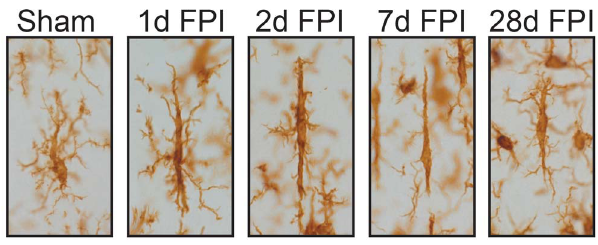
Figure 2. Rod microglia morphology and alignment post-FPI. Representative images of Iba1-positive microglia in the cortex of sham- injured and FPI rats. Sham-injured microglia showed a sausage-like cell body but no polarization of processes. However, as early as 1 day post- injury the retraction of planar processes was evident giving rise to rod morphology. Rod microglia continued to retract their planar processes at day 2 post-injury, and by day 7 there were few planar processes visible. By day 28, the cell body had begun to become more rounded and planar processes were returning.